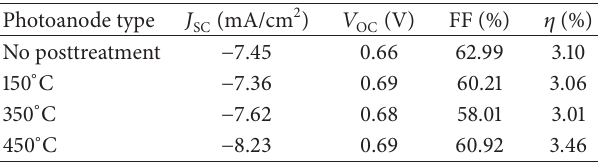
Table 2: Photovoltaic parameters of the DSSCs with J - V curves shown in Figure